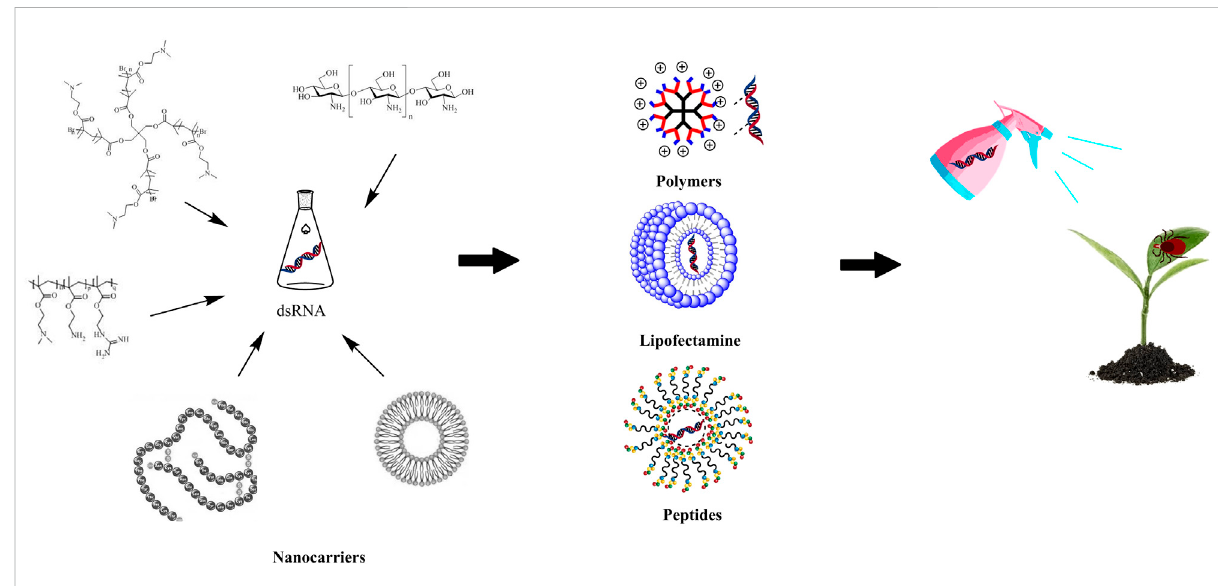
Application of nanocarriers in improving the stability of